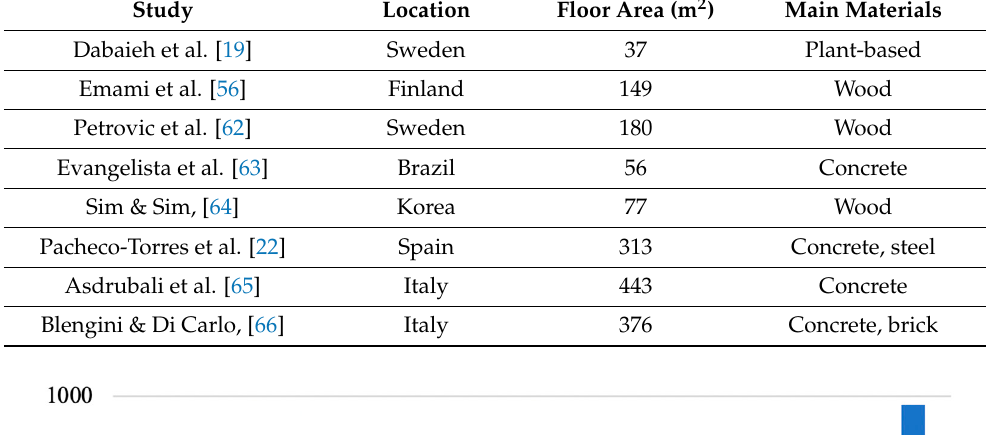
Table 8. Selected previous detached house LCA studies used to position the GWP from the fiberglass house of this study.